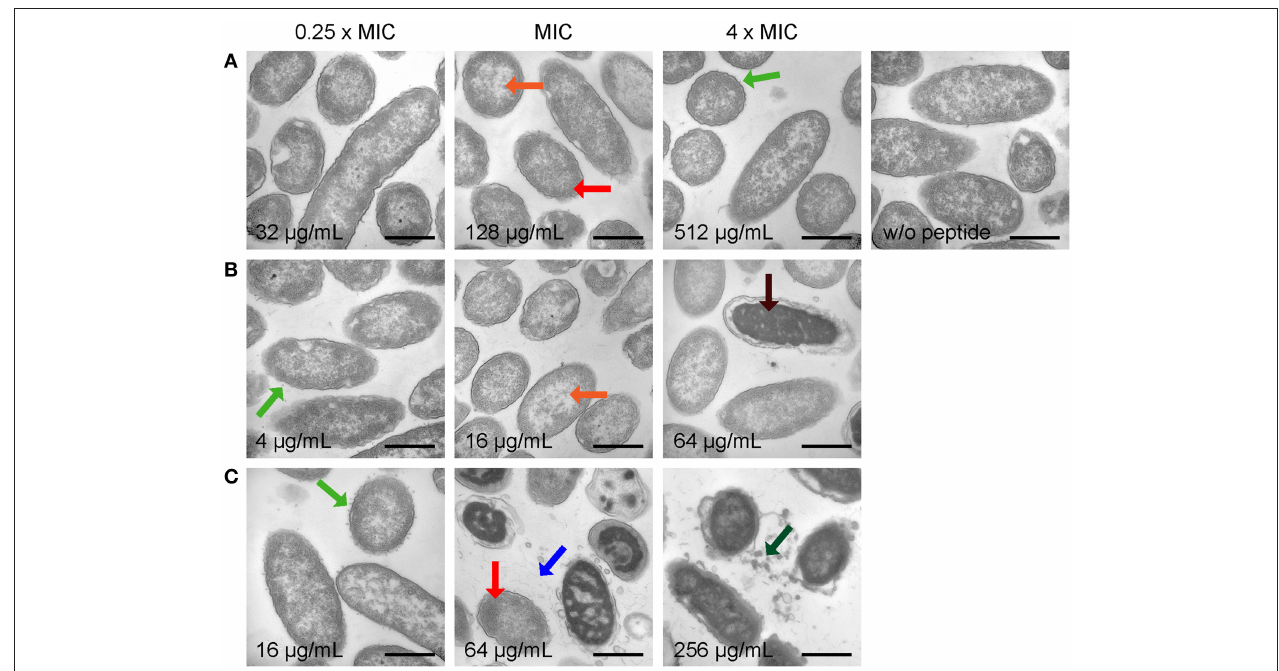
FIGURE 3 | Electron microscopy images of P. aeruginosa DSM 1117 incubated with Api137 (A), Api795 (B), and Api794 (C) at concentrations corresponding to 0.25 × MIC, MIC, and 4 × MIC for 1 h using cell densities of 5 × 10 8 CFU/mL. Black bars represent 500 nm. Morphological changes are indicated with arrows: dissociated fragments (blue), small vesicle release (green), large vesicle release (dark green), relocalized DNA (orange), slightly clustered ribosomes (red), and extremely clustered ribosomes (dark